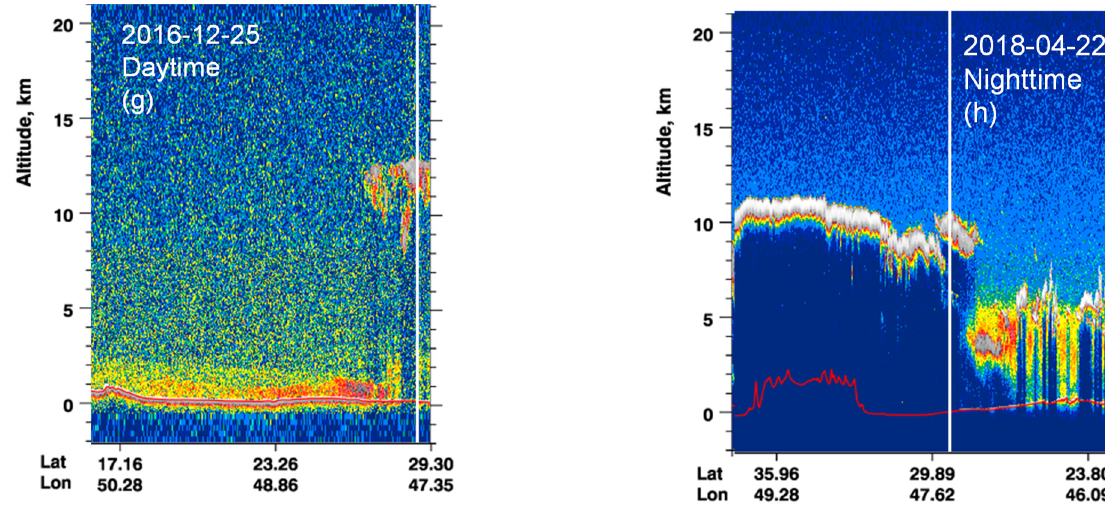
Figure 7. ( a , c ) Daytime images of SDS near Kuwait City in late spring and early fall, respectively. ( a ) Mostly to the north of the city. ( b ) Mostly to the south of the city. ( c , d ) Images in the late spring and winter, respectively, of SDS observed in Kuwait City and its surroundings. The images show dust layers in intense convective activity in the springtime image ( c ) and remnants of convection in the winter ( d ). ( e , f ) Backscatter images of dust storms in daytime summer and nighttime winter, respectively. ( g , h ) Daytime winter and nighttime spring dust storms, respectively, near Kuwait City.